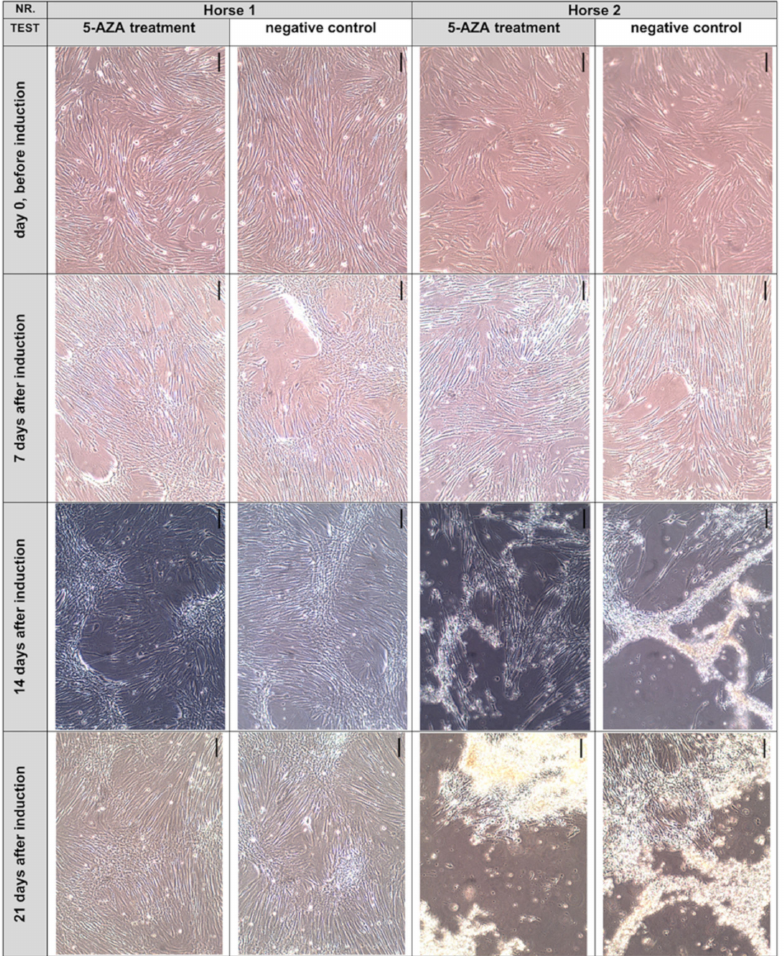
Figure 4. Morphology of abdominal adipose tissue-derived stem/stromal cells (ASCs) obtained by collagenase digestion before (day 0) and after (day 7, 14 and 21) exposure to 5-azacytidine (5-AZA) (exemplary for n = 2 donors). The cells of horse 1 exhibited the typical fibroblast-like morphology and moderate “dome” formation. Cell detachment was seen in horse 2 after two to three weeks as well as atypical small cells indicative of this. No differences between the induced and negative control cells were visible in either horse. Scale bar: 0.1